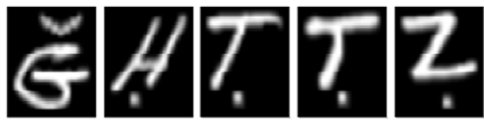
Fig. 2. A sample of Berber-MNIST dataset content